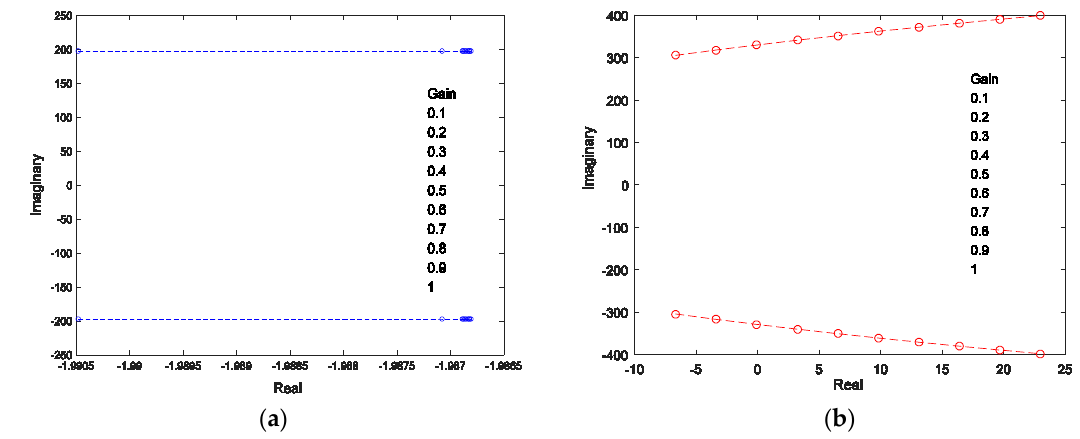
Figure 16. Root locus of closed loop system vs. feedforward gain. ( a ) Root locus of conjugated pole 1; ( b ) Root locus of conjugated pole 2